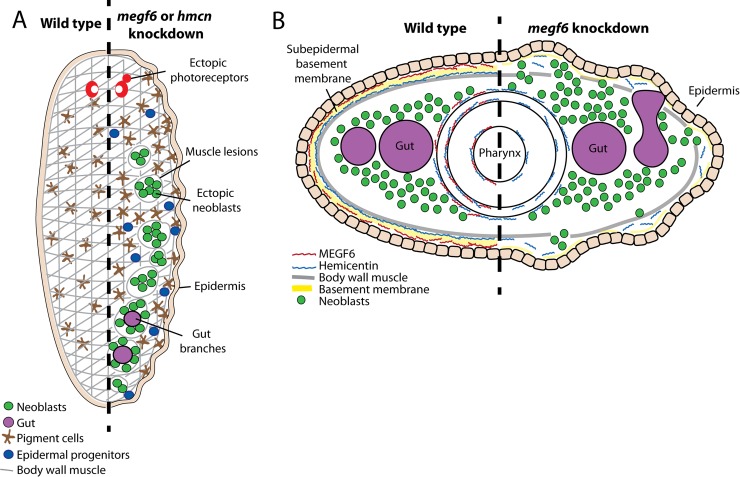
Model of the localization and knockdown phenotypes of megf6 and hemicentin.A) Summary of the phenotypes induced by knockdown of megf6 or hemicentin, which include wrinkled epidermis, muscle lesions associated with ectopic neoblasts and gut branches, and mis-localized cell types such as pigment cells, photoreceptors, and epidermal progenitors. B) Model of a transverse cross-section showing the proposed locations of MEGF6 and hemicentin proteins, hypothesized based on mRNA expression and knockdown phenotypes. The left half models a wild-type animal, while the right half shows the effect of megf6 knockdown. Both megf6 and hemicentin are required for proper organization of the subepidermal basement membrane: in the absence of MEGF6 protein, attachment of the basement membrane is impaired, and cell types localize ectopically to the subepidermal space. These cells include neoblasts and gut cells, which normally do not contact the subepidermal basement membrane. The same effects are observed in the absence of hemicentin.